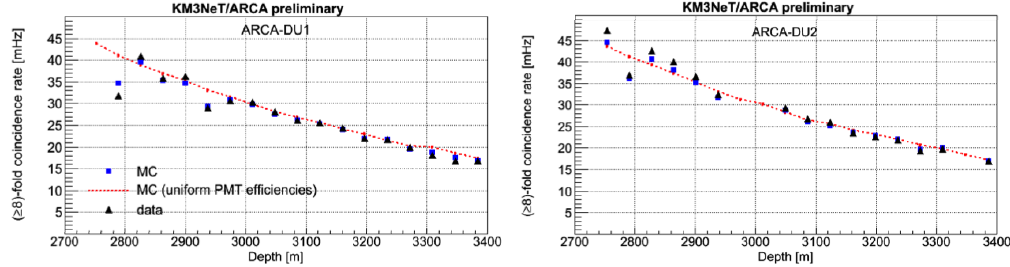
Figure 6. ≥ 8-fold coincidence rate as a function of the depth for the two ARCA DUs. The black points are the data. The red dashed lines are the base expectation from an ideal Monte Carlo with uniform PMT e ffi ciencies which neglects the di ff erences between individual PMTs as determined from in-situ calibration. The blue points are the Monte Carlo simulations where PMT e ffi ciencies have been taken into